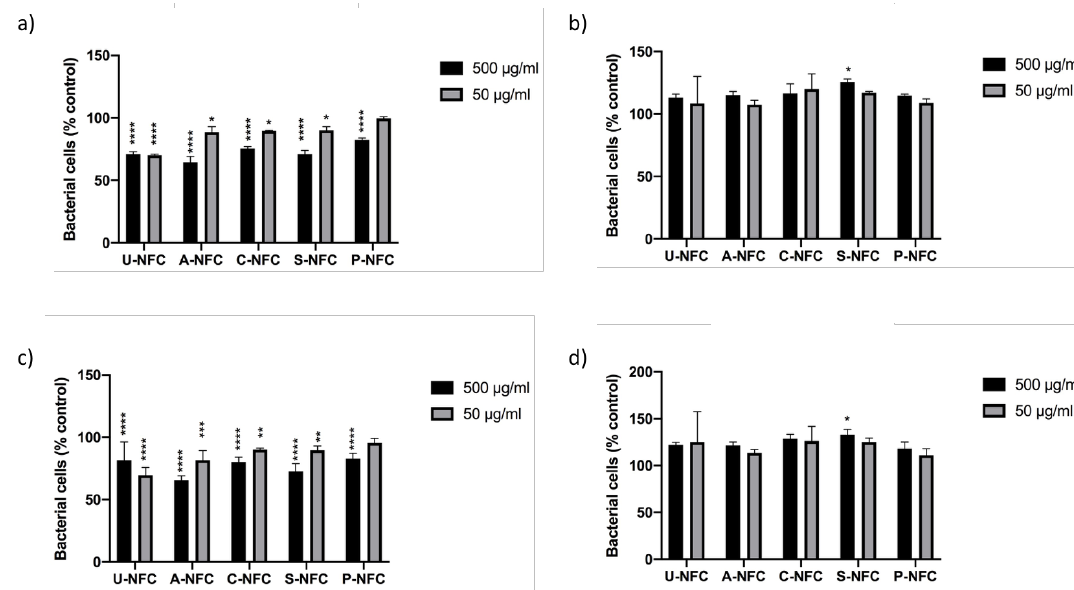
Figure 5. Bacteria survival after exposure to the NFC materials at different time points. ( a ) E. coli , 3 h; ( b ) L. reuteri, 4 h; ( c ) E. coli , 8 h; and ( d ) L. reuteri , 8 h . Data are expressed as percentage of the control (untreated bacteria) and presented as mean ± SEM of at least two independent experiments. Significant results as compared with the control area marked with asterisks (* p < 0.05, ** p < 0.01, *** p < 0.001, **** p < 0.0001).